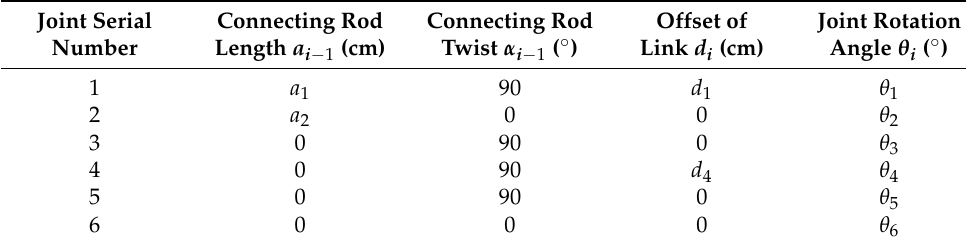
Table 1. The D-H parameters of the robotic arm. Joint